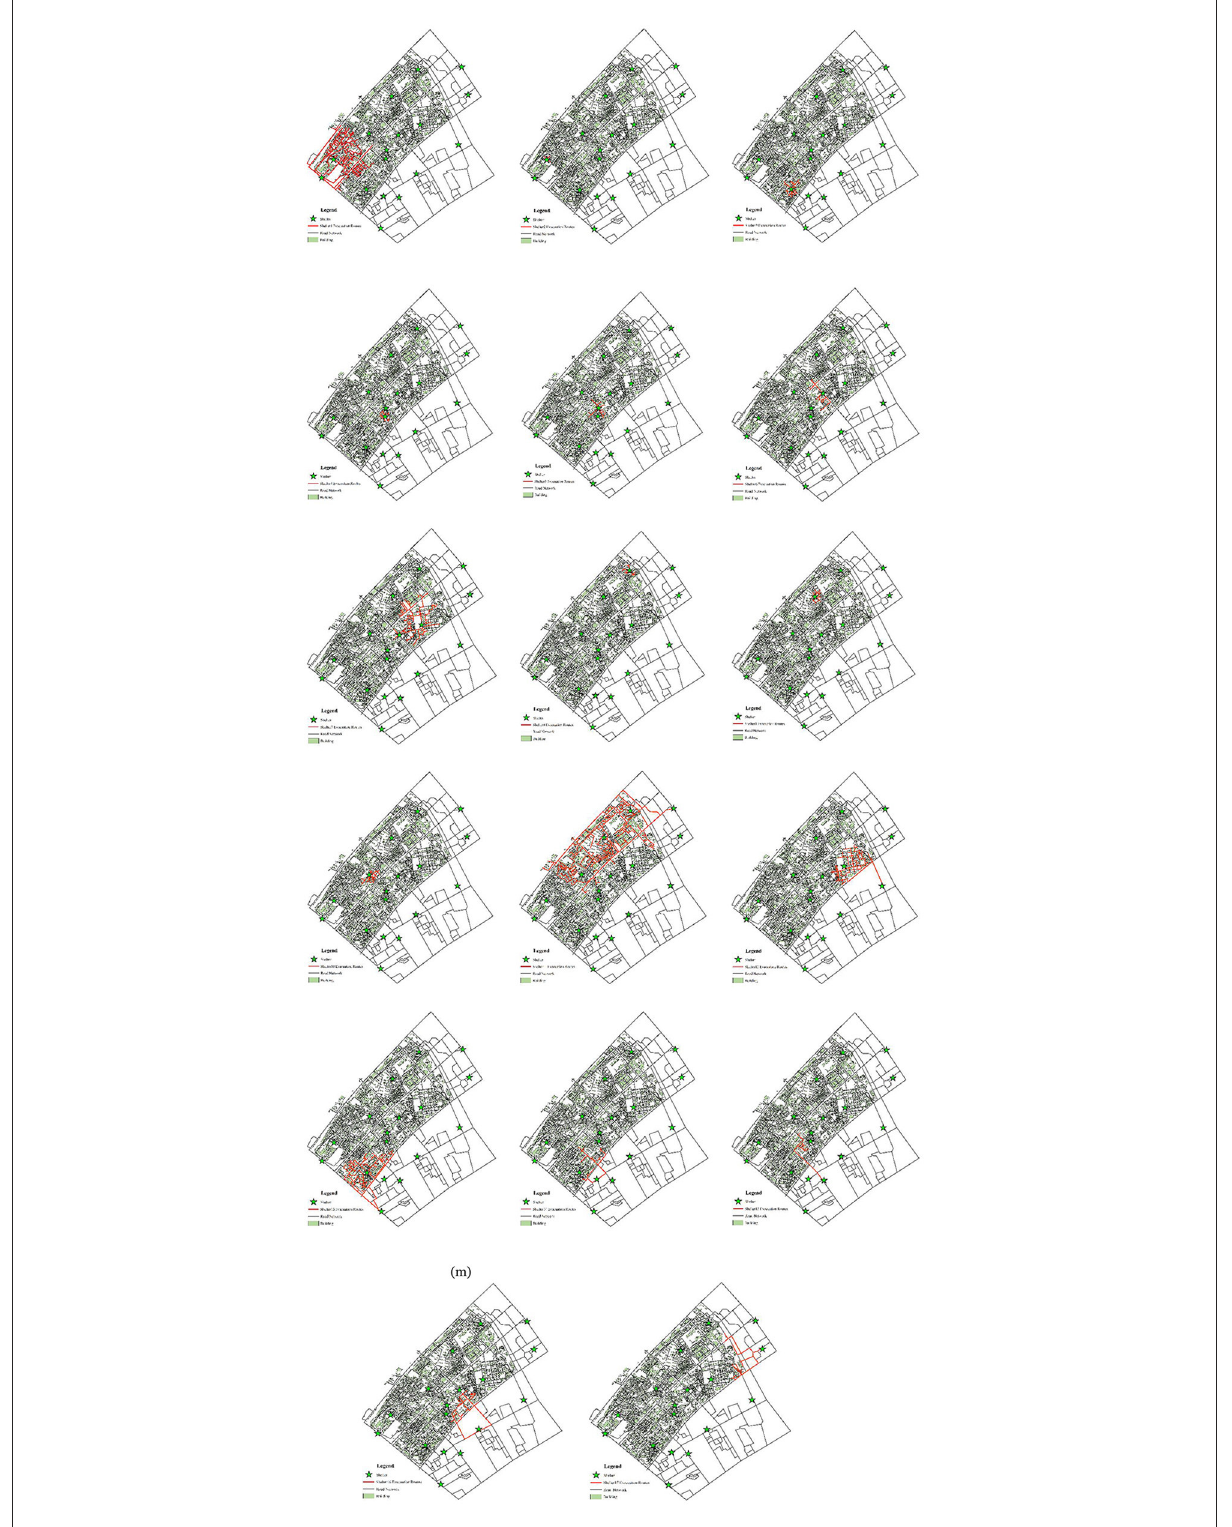
FIGURE12 Evacuation routes to each